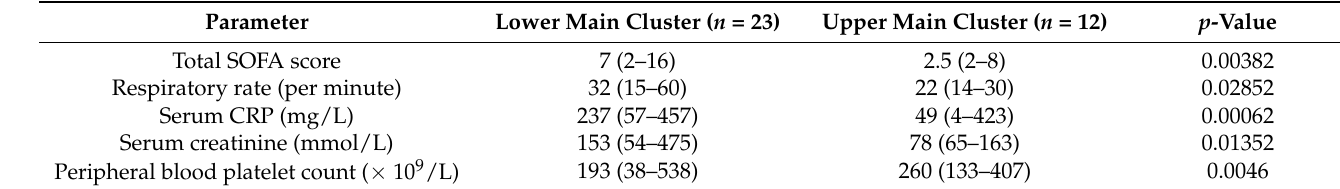
Table 3. Subset classification of Sepsis-3 patients. A comparison of the lysophosphatidylcholine serum profile for the two Sepsis-3 patient subsets identified in the unsupervised hierarchical clustering analysis presented in Figure 2, i.e., the majority of Sepsis-3 patients localized in the lower main patient cluster and the minor subset localized in the upper main cluster. The results are presented as the median and variation range. The Mann–Whitney U test was used for the statistical